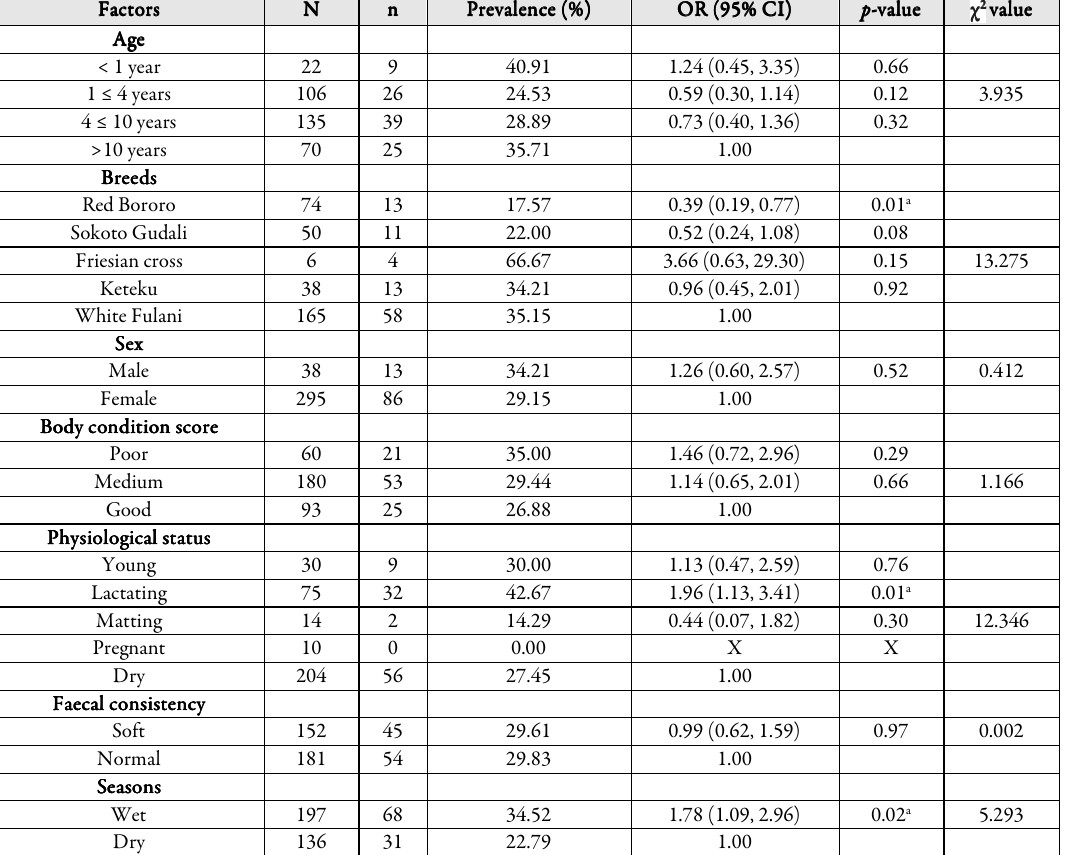
Table 2. Prevalence and epidemiological variables that were investigated as potential risk factors for bovine Cryptosporidium detection in Kwara State,